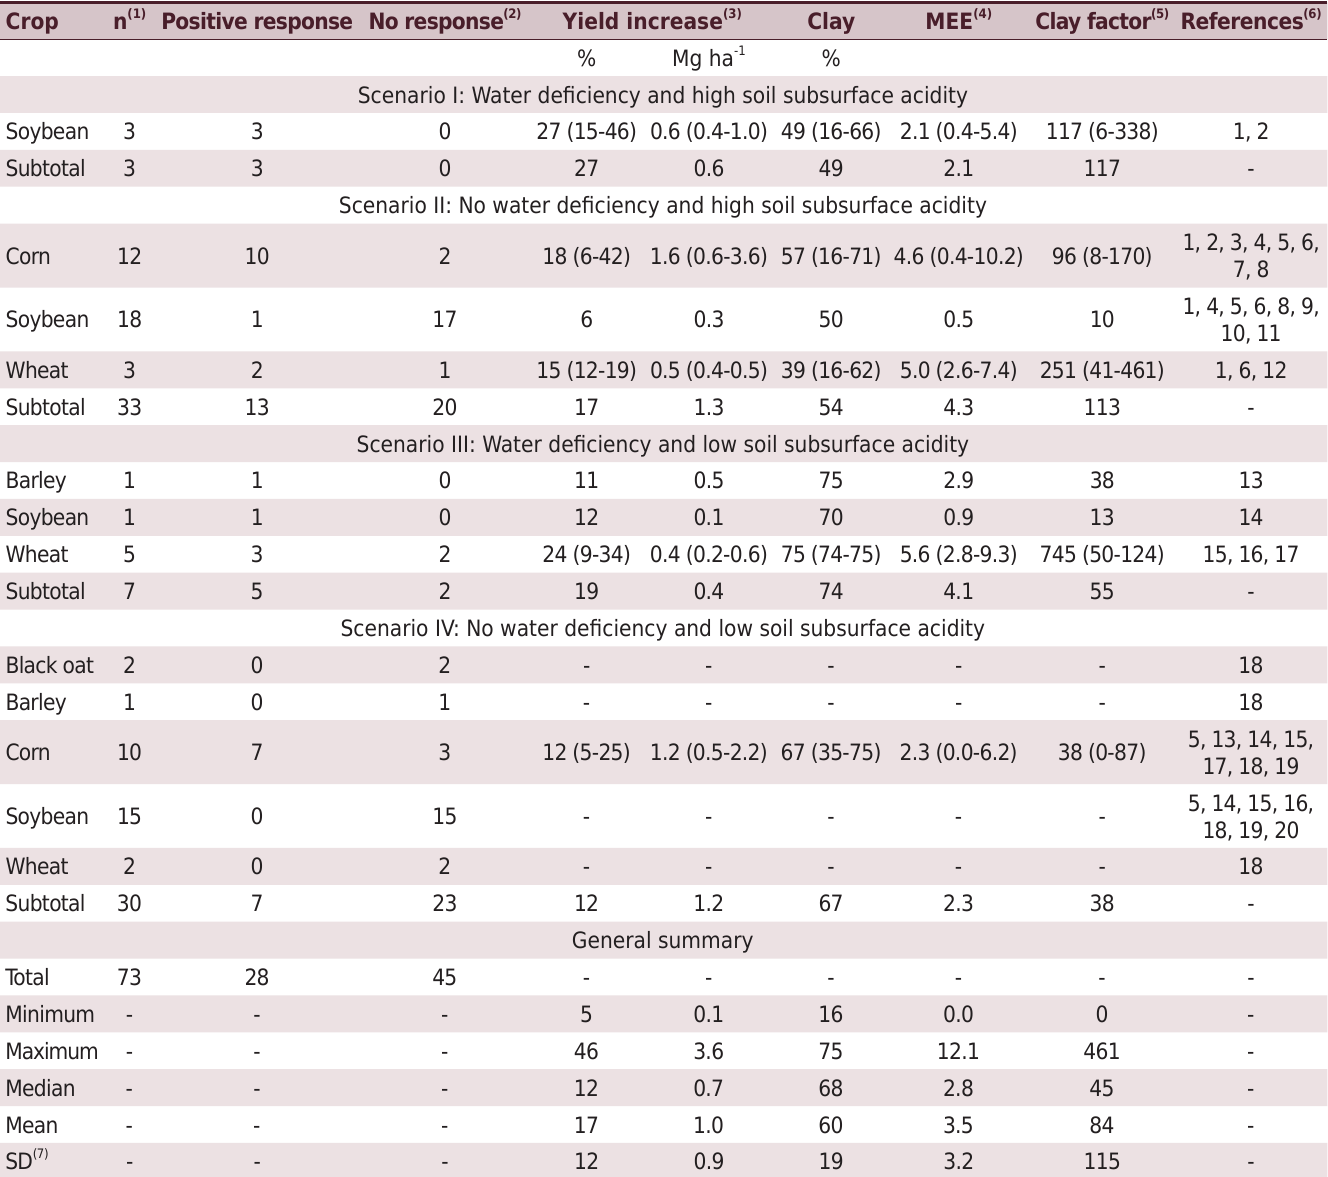
Table 2. Increase in grain yield of crops as a function of gypsum rates applied under different conditions of subsurface acidity and water deficiency in subtropical soils under no-tillage in Southern Brazil Crop n (1) Positive response No response